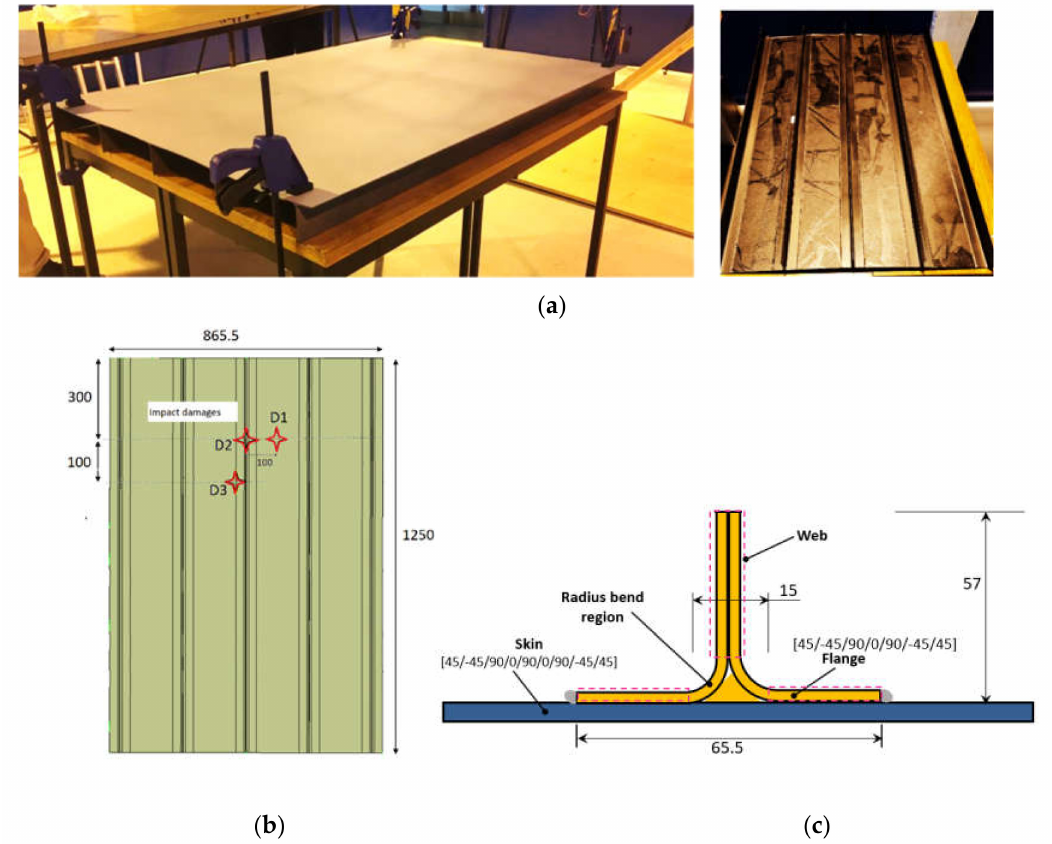
Figure 1. Stiffened composite flat panel ( a ) finished external surface clamped for infrared thermography/Phased Array (IRT/PA) inspection and panel rear face ( b ) schematic of barely visible impact damages (BVID) locations on the panel front face ( c ) T-stringer